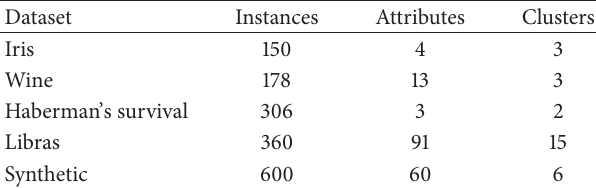
Table 4: Testing dataset